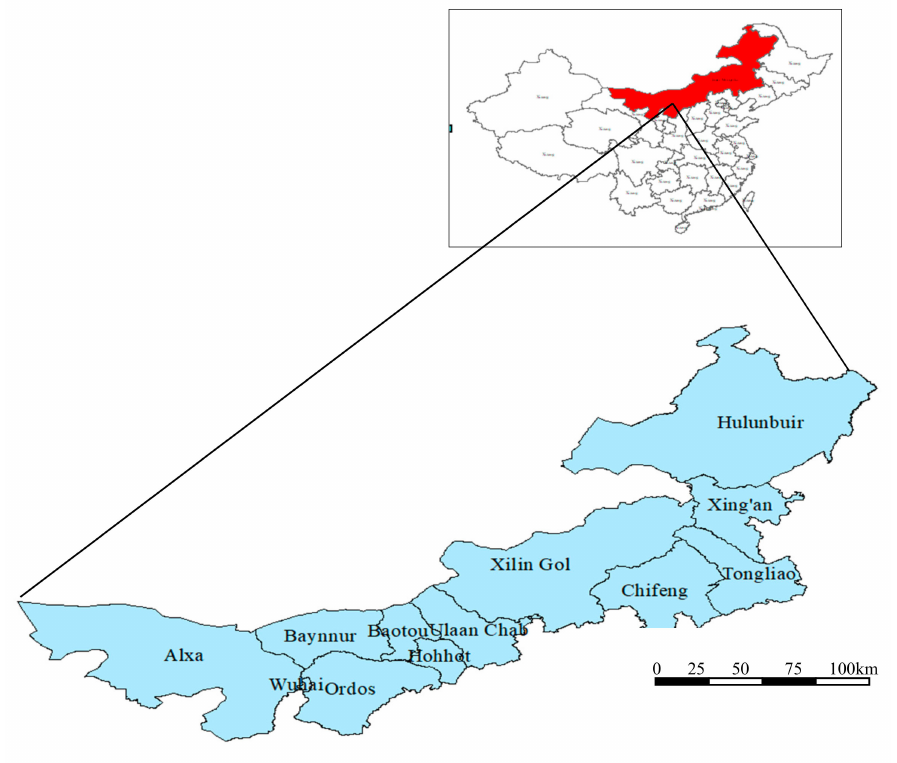
Figure 1. The location of 12 cities in Inner Mongolia,